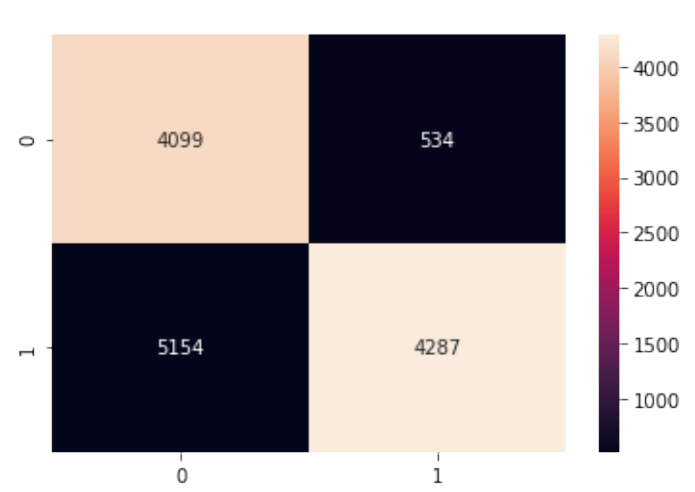
Figure 13. Binomial Logistic Regression confusion